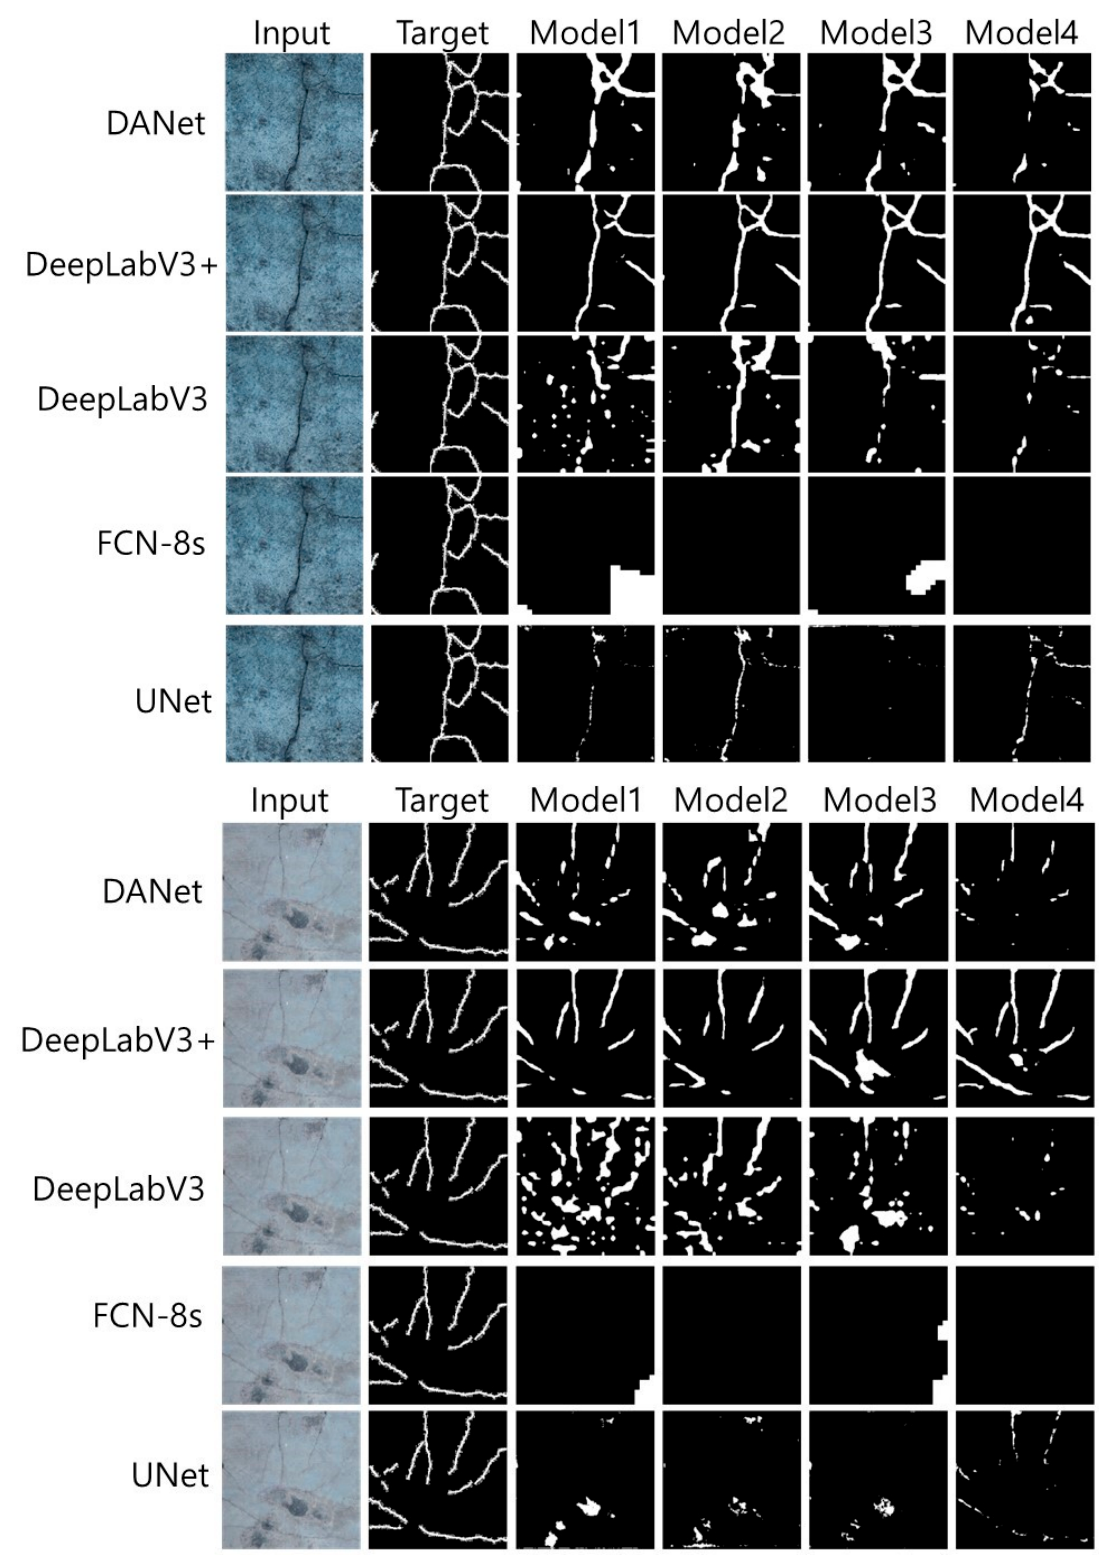
Figure 11. Typical images predicted by segmentation models.